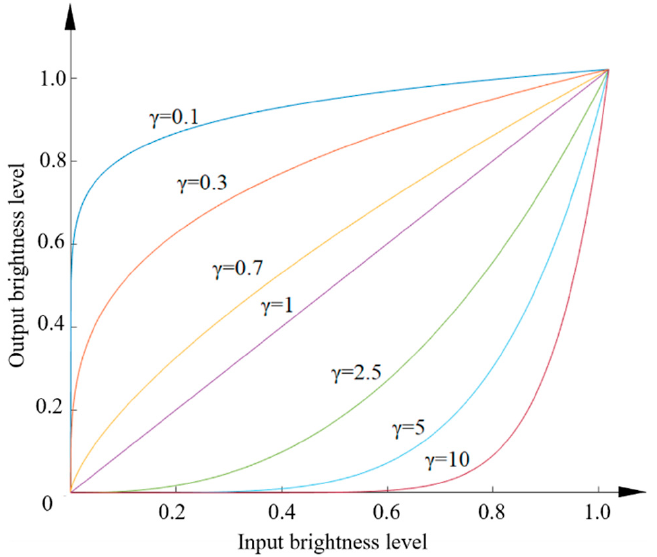
Figure 2. The gamma function curve with different values.